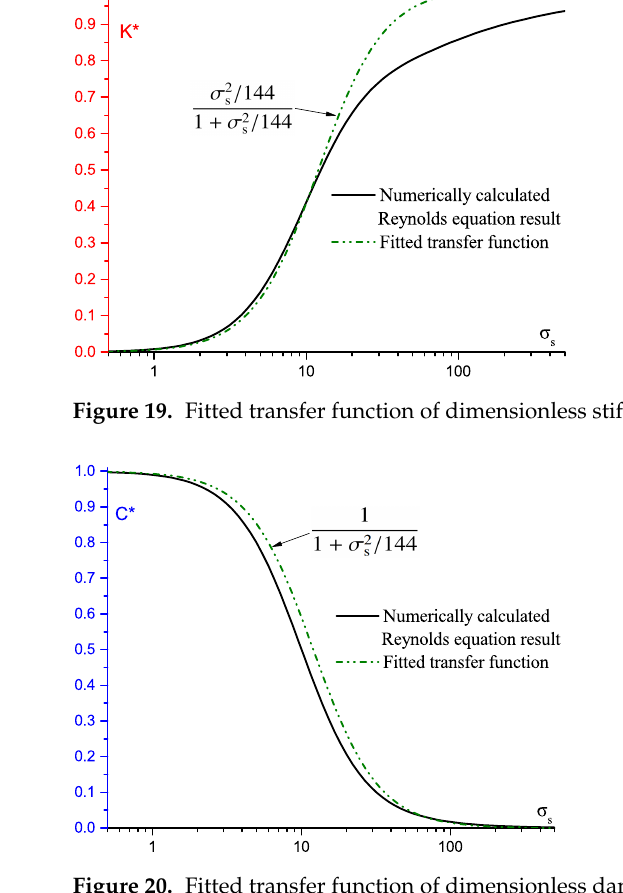
Figure 20. Fitted transfer function of dimensionless